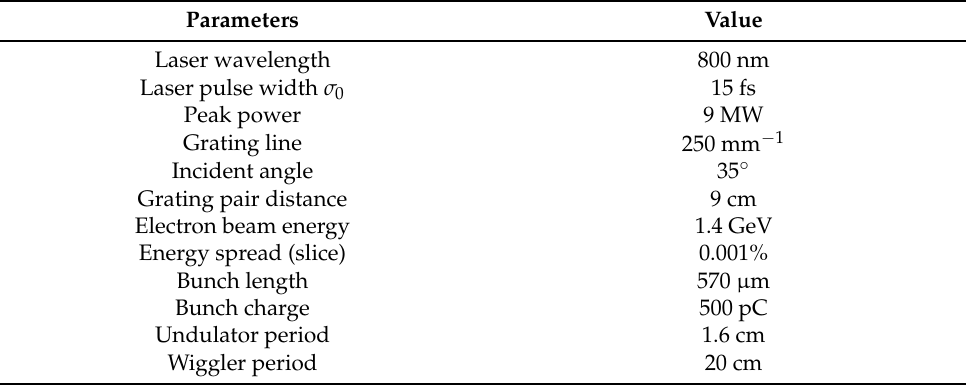
Table 1. The parameters of the laser system and electron